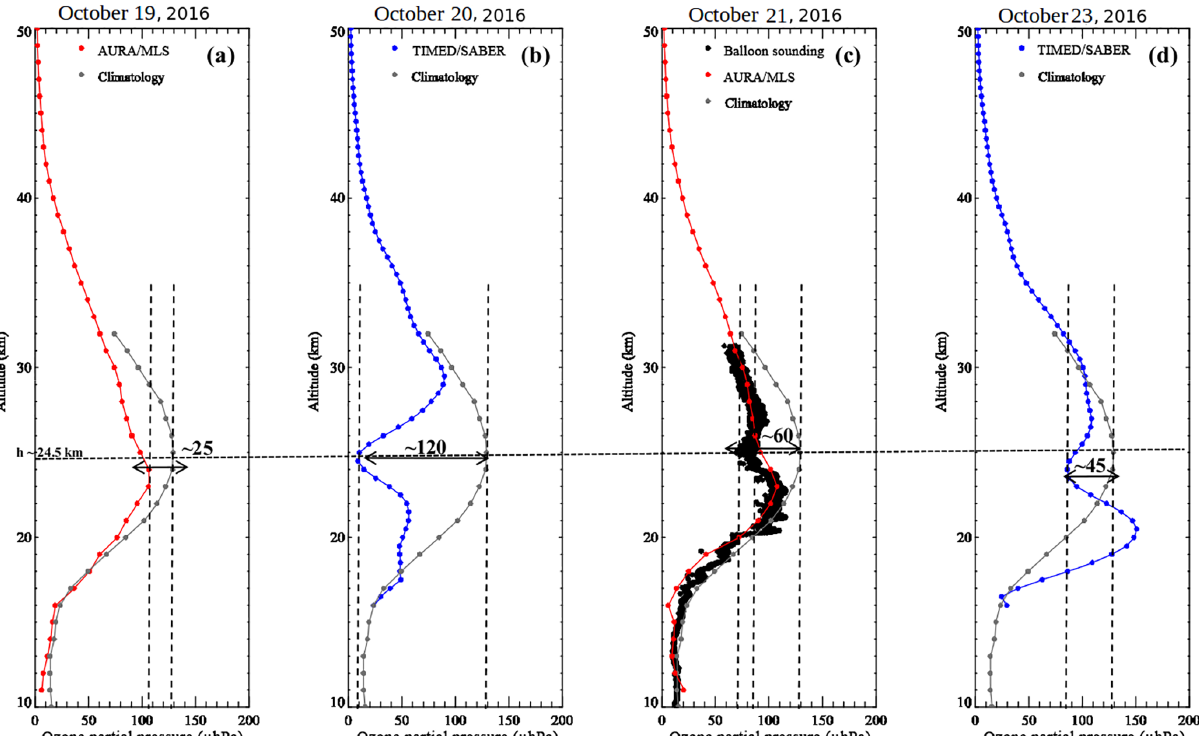
Figure 3. Ozone partial pressure profile as obtained by the ozonesonde (black), AURA/MLS (red), TIMED/SABER (blue) and climatology from ozonesonde balloons campaigns between 1996 and 1998 (grey) (following Guarnieri et al.,